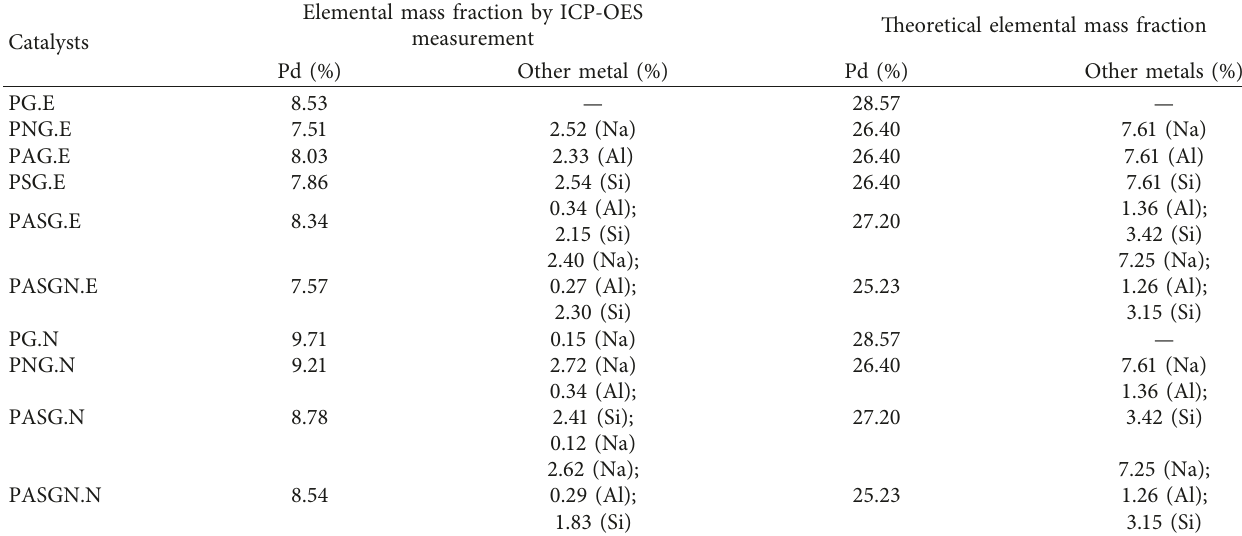
4 . Theoretical elemental mass